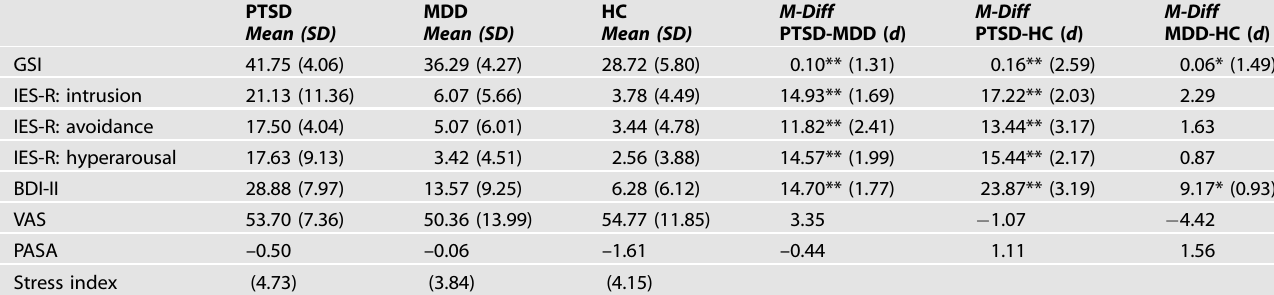
PTSD post traumatic stress disorder, MDD major depression disorder, HC healthy control, SD Standard deviations, M-Diff Mean difference, GSI Global Severity Index, IES-R impact of event scale, BDI-II Beck depression inventory, VAS visual analog scale, PASA primary appraisal secondary appraisal, d effect size Cohen ’ s d.